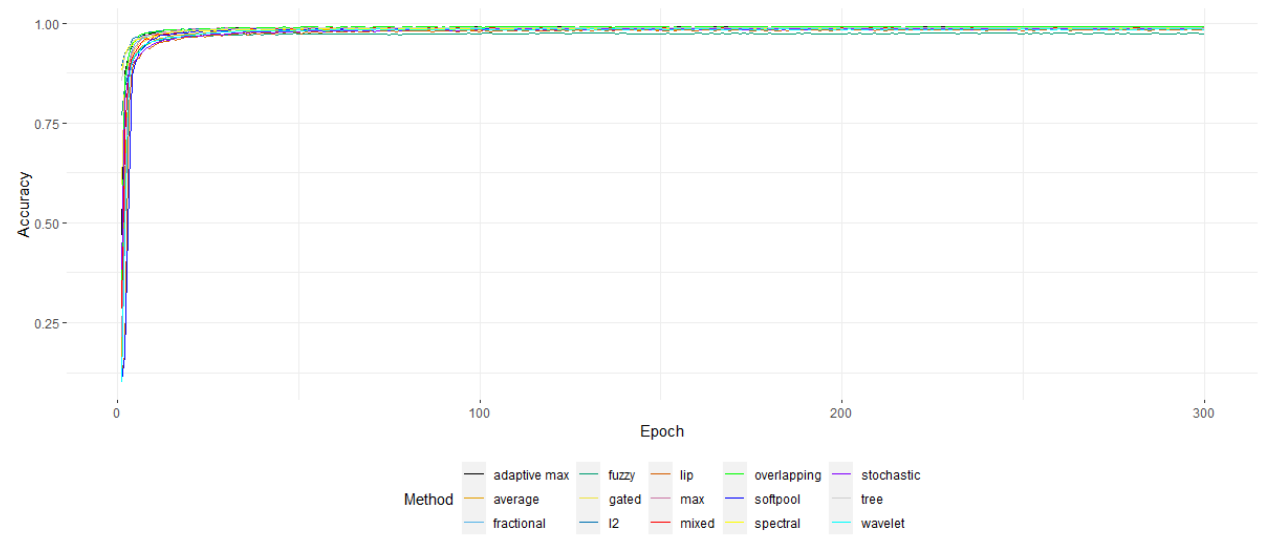
Figure 10. The top 1 accuracy of the models for the MNIST dataset over the